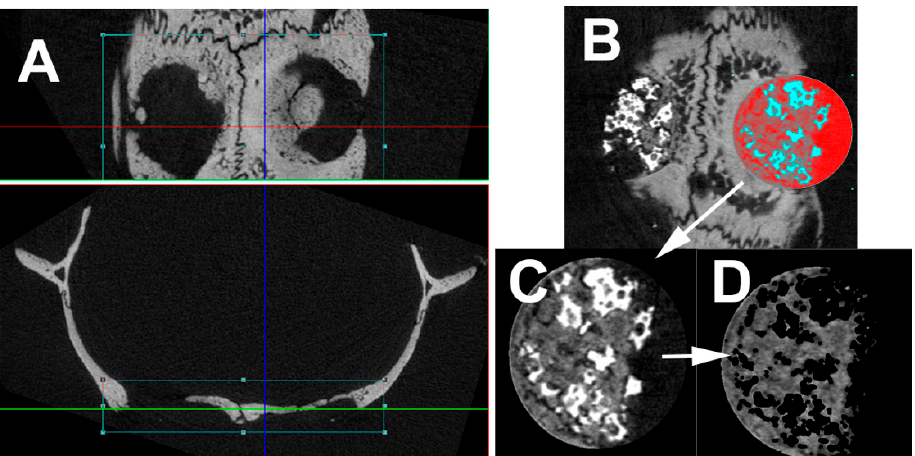
Figure 2. Picture showing the micro-computed tomography (CT) evaluation. ( A ) First the slices have been placed in correct orientation for reconstruction. ( B ) Thereafter a circular region of interest (diameter 5 mm) has been placed into the defect. ( C ) by defining the first and last slice with bone, the volume of interest was defined. ( D ) Semi-automated evaluation protocol removed very dense regions (Actifuse, NanoBone ® ) as well as air and evaluated the volume of interest with respect to the defined parameters.